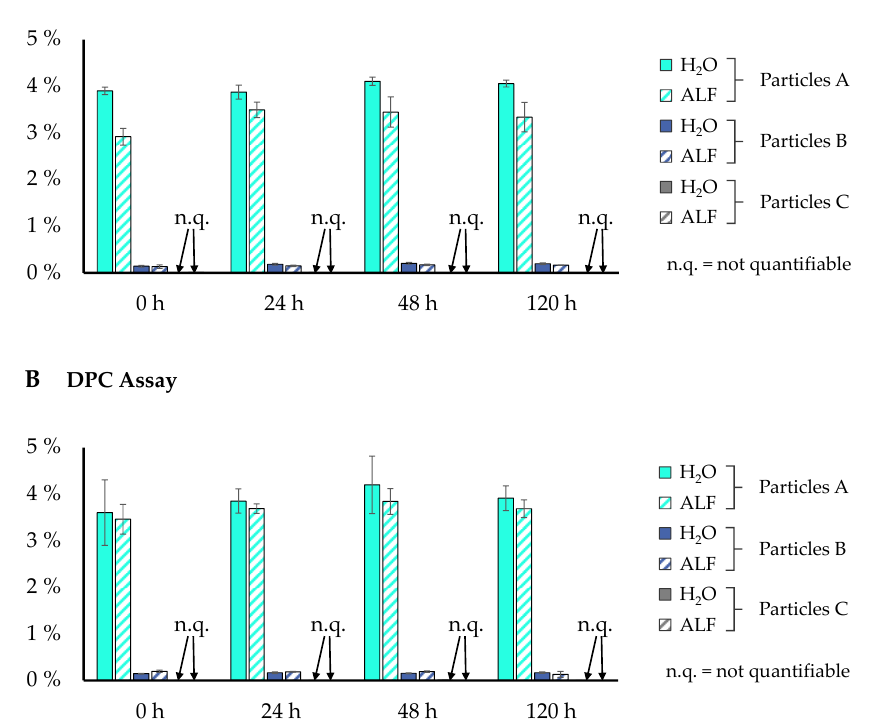
Figure 3. Release of chromium from Cr 2 O 3 particles in different media. Cr 2 O 3 particles measuring 1.0 mg/mL were either incubated in ultrapure water (pH 7.0) or artificial lysosomal fluid (ALF) (pH 4.5) for 0 h, 24 h, 48 h, or 120 h. The remaining particles were removed from the supernatant by centrifugation as described in Materials and Methods. Total chromium release was quantified by atomic absorption chromatography (AAS) ( A ) or Cr(VI) release by a colorimetric DPC assay ( B ) by applying the chromogenic dye 1,5-diphenylcarbazone. Mean values of 3 independent determinations ± SD are shown.